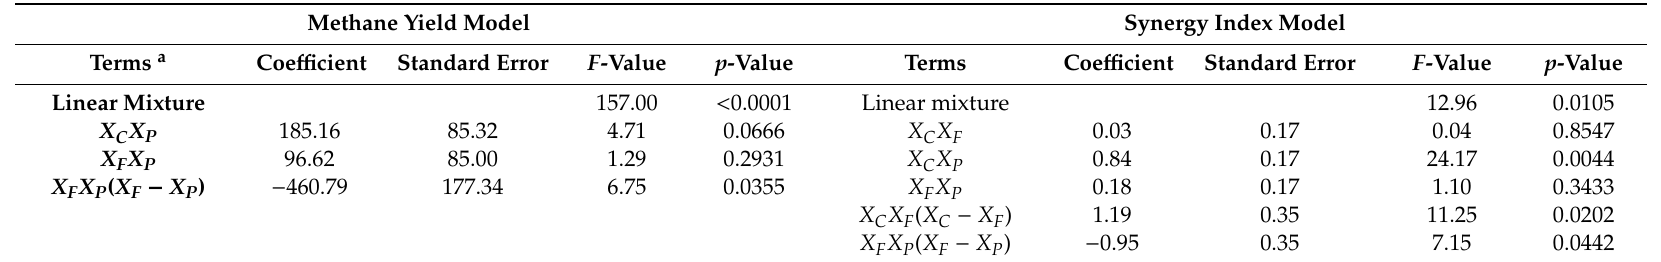
Table 4. Statistical significance of the model coe ffi